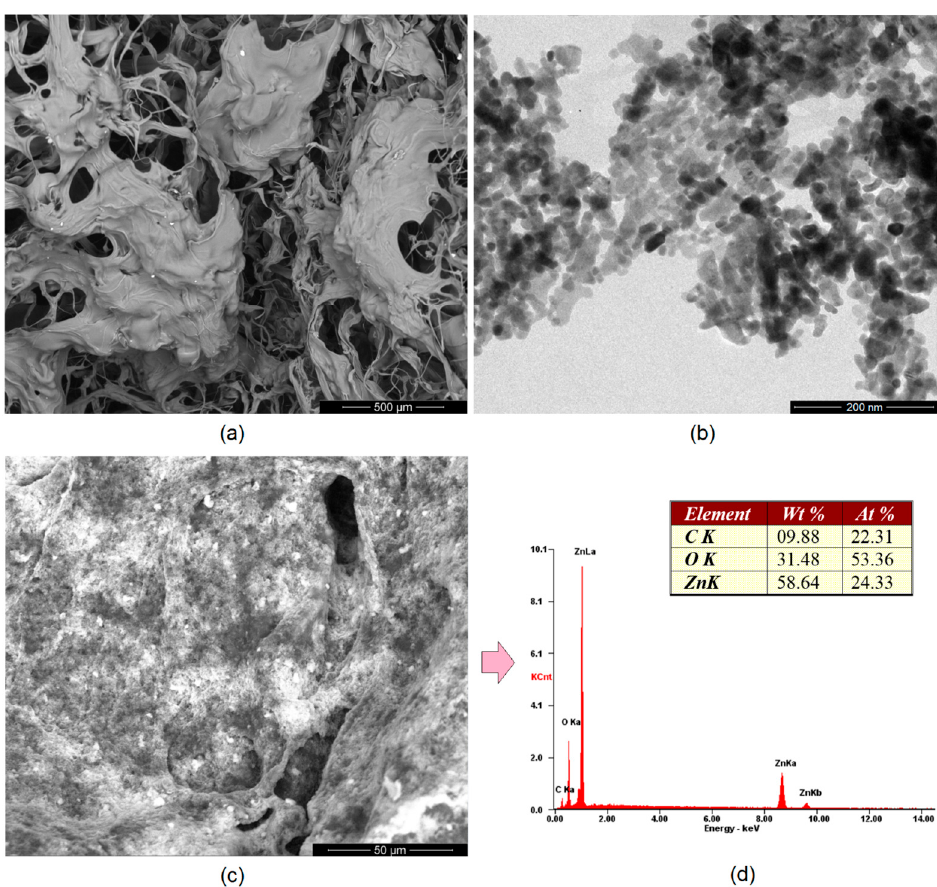
Figure 5. ( a ) SEM microphotograph of the chitosan hydrogel crosslinked with amino acids; ( b ) TEM microphotograph of the prepared ZnO nanoparticles; ( c ) SEM microphotograph of the hydrogel modified with ZnO nanoparticles (CS-ZnO-6); and ( d ) elemental analysis of the sample surface (CS-ZnO-6) .